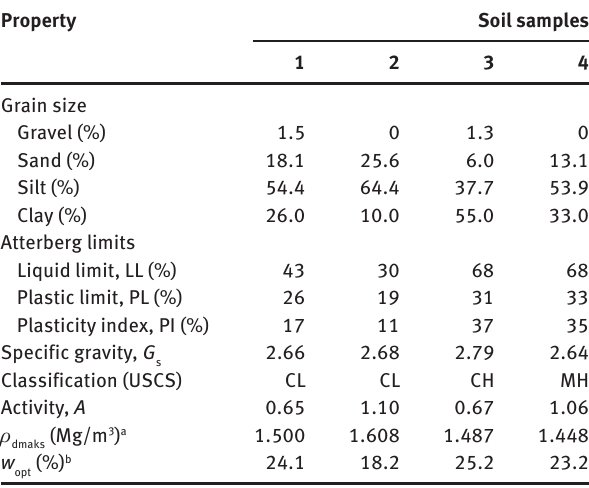
Table 1 Physical properties of the soils used in the study.